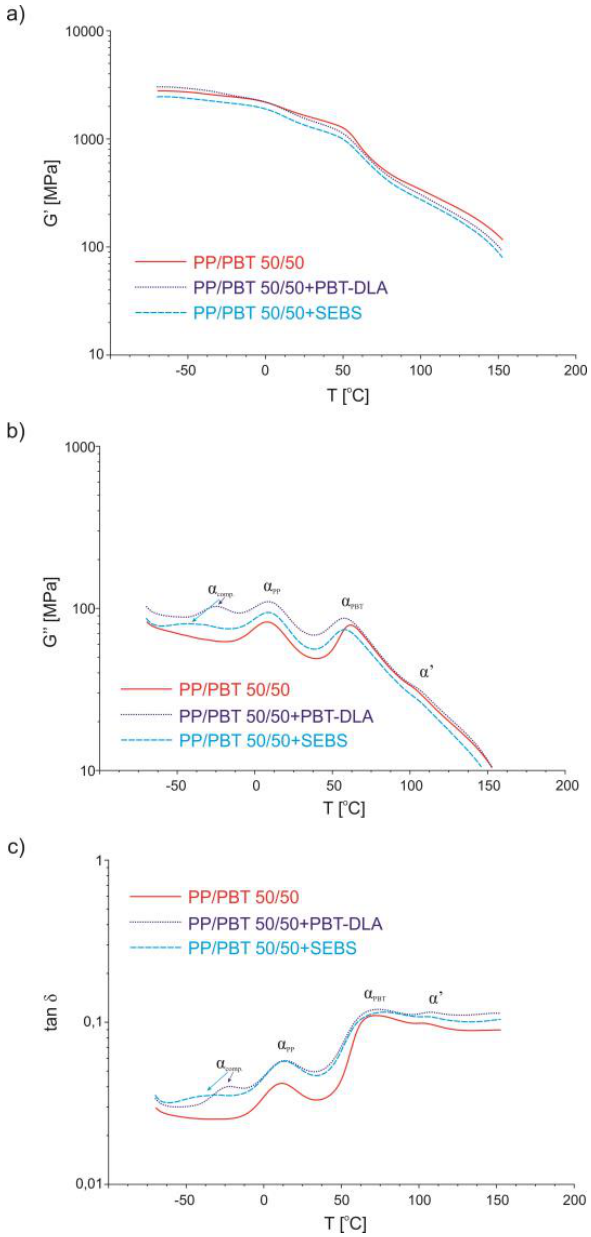
Figure 15. Dynamic thermomechanical analysis (DMTA) analysis of compatibilized PP / PBT blends: ( a ) storage modulus; ( b ) loss modulus; ( c ) tangent of delta. Thermograms of the loss modulus for blends after addition of compatibilizers (Figure 15b) revealed additional maxima corresponding to the amorphous phase of the compatibilizer (marked as α comp.